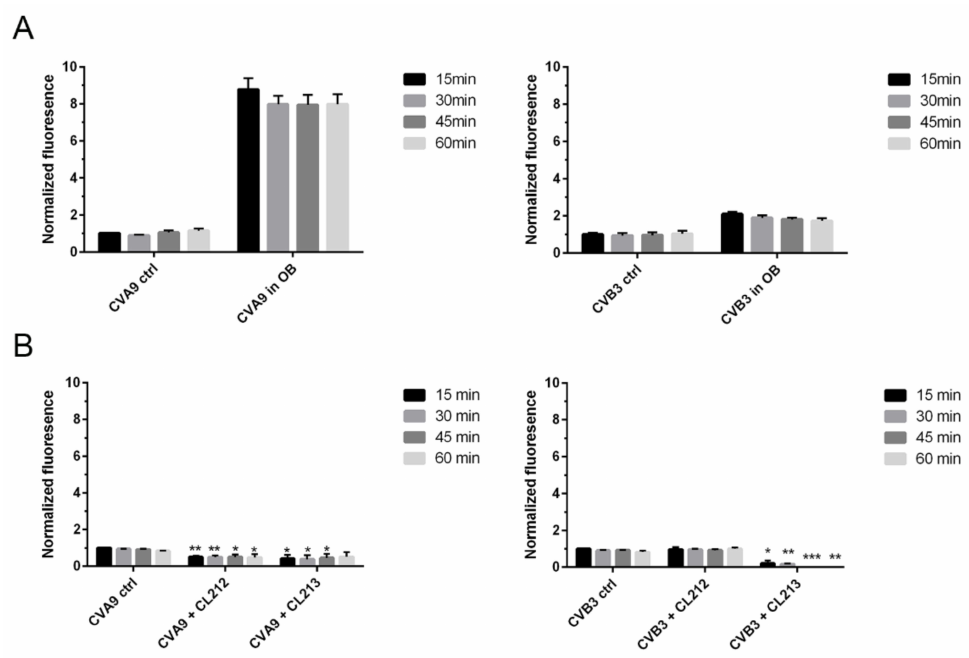
Figure 5. The effect of CL212 and CL213 on virus uncoating. CVA9 or CVB3 (0.5 µ g) were incubated in stabilizing 2 mM MgCl 2 /PBS buffer (ctrl) or in an opening buffer OB ( A ), or in 2 mM MgCl 2 /PBS buffer with or without 100 µ M molecules ( B ) for 1 h at +37 ◦ C. After the incubation, Sybr Green II was added and fluorescence measurements were taken at 15-min intervals for one hour. The fluorescence is normalized against the 15 min ctrl virus and the data are presented as mean ± SEM from two repeats. From comparison to control samples significant p -values are marked with an asterisk above the respective sample columns: p < 0.05 *, p < 0.01 **, and p > 0.001